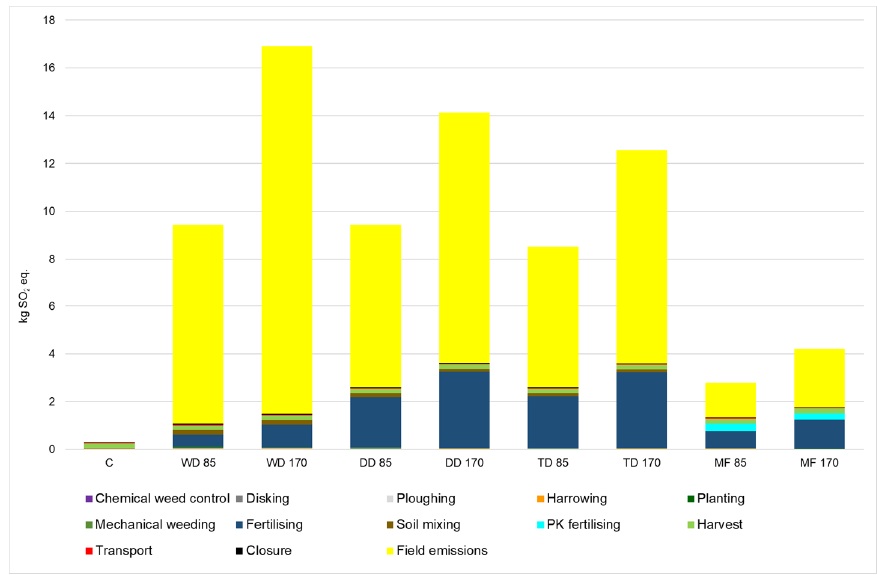
Figure 5. Terrestrial acidification per 1 Mg d.m. of miscanthus in different fertilisation treatments.